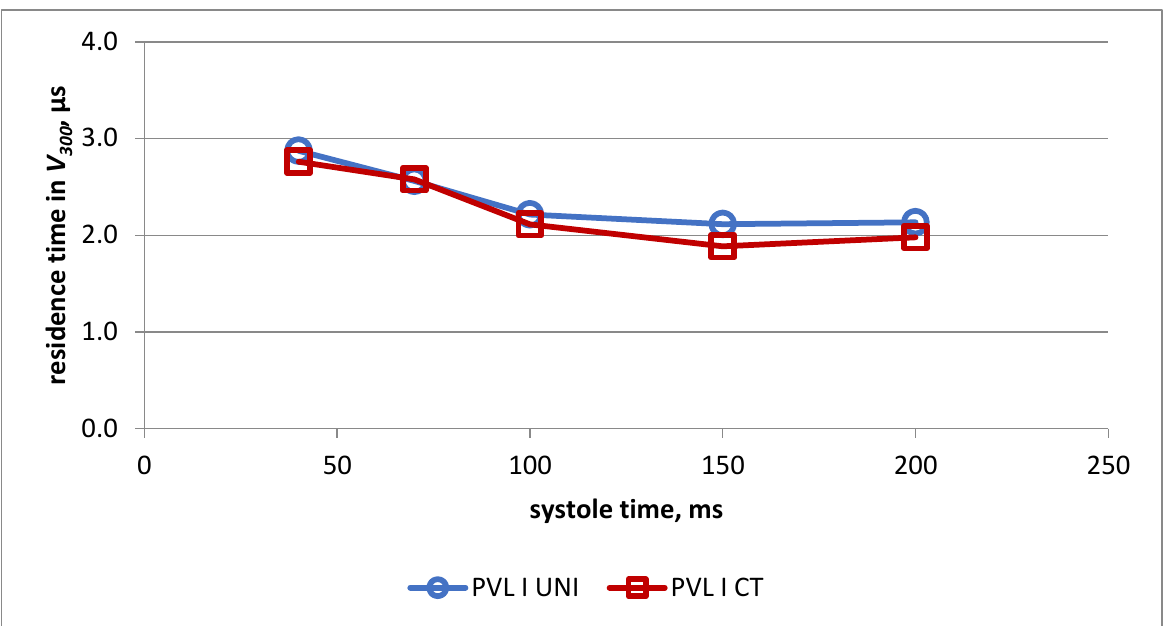
Figure 6. Volume with shear stress > 300 Pa in universal model (UNI) and real-life model (CT) for PVL model I.